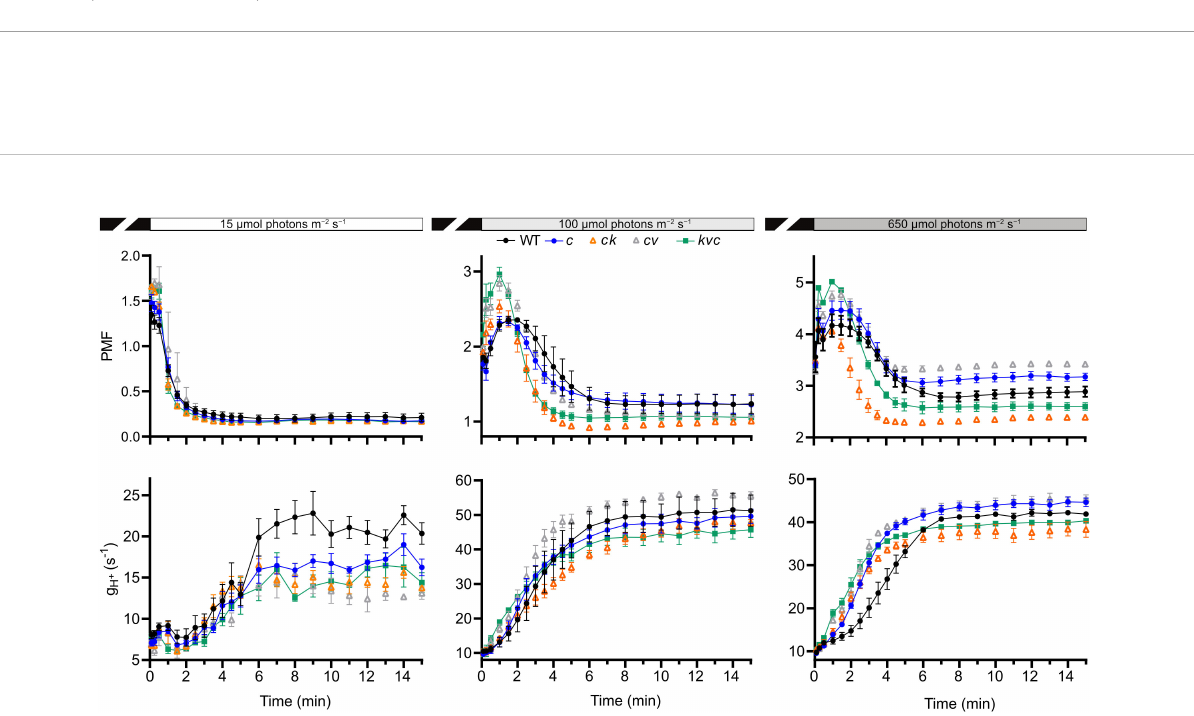
FIGURE 4 Kinetics of proton motive force and H + conductivity through ATP synthase. Electrochromic shift measurements (ECS) were performed on 30 min dark-acclimated wild-type and mutant plants grown in short-day conditions (120 µmol photons m − 2 s − 1 ) and illuminated at the indicated intensities. Total proton motive force (PMF) and ATP synthase H + conductivity (g H+ ) were calculated from ECS decay kinetics as described in Methods. The plotted data are means ± S.E.M. ( n = 6 plants). WT – Col-0 , c – clce-2 , k – kea3-1 , v – vccn1-1 , and kvc – kea3-1vccn1-1clce-2. Induction kinetics for the fi rst 210 illumination are presented in Supplementary Figure 4.